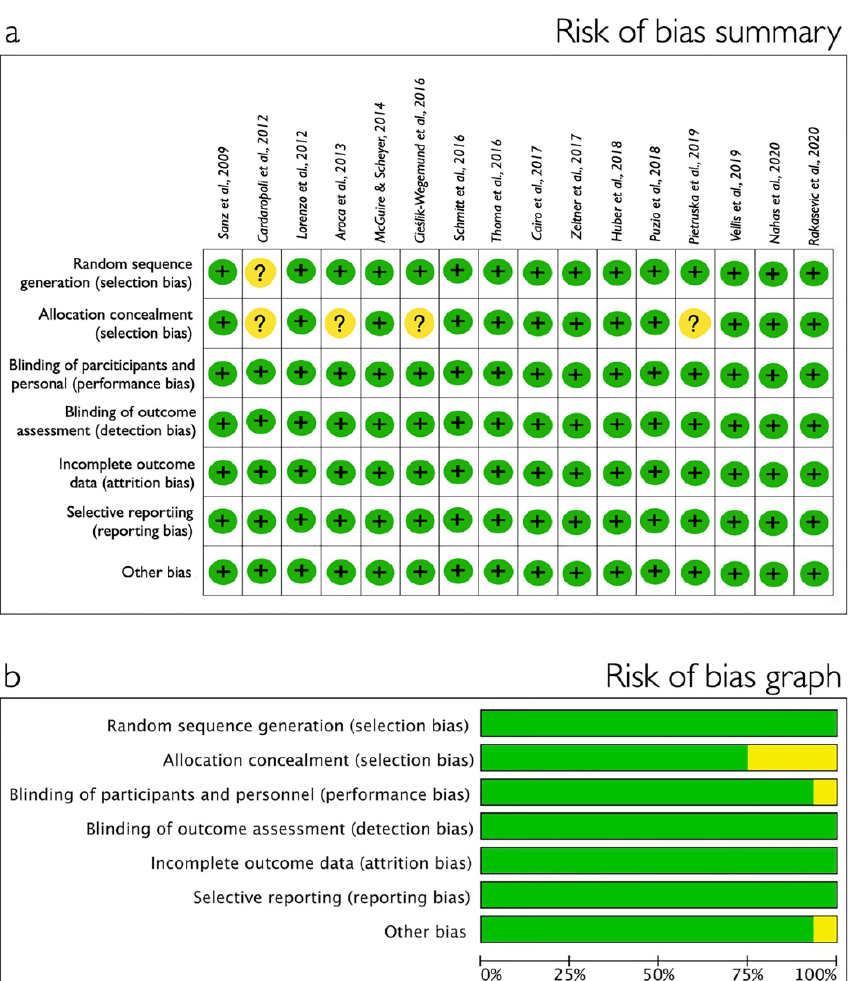
Figure 3. Randomized clinical trial quality assessment using the Cochrane Handbook for Systematic Reviews of Interventions [23]. ( a ) Risk of bias summary: studies were considered as having high (red); moderate (yellow) or low (green) risk of bias. ( b ) Risk of bias graph: each risk of bias item presented as percentages across all included studies.